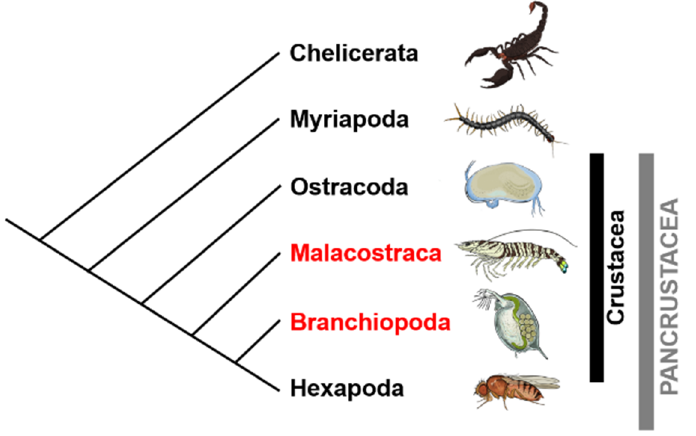
Figure 1. Phylogeny of extant arthropods. The branching pattern is based on [1] with some modifi- cations. Crustaceans are one of the four major groups of arthropods and consist of Ostracoda, Malacostraca, and Branchiopoda.